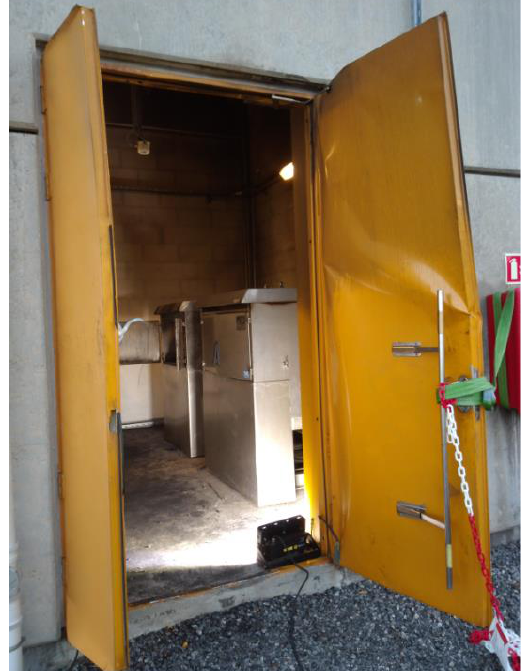
Figure 7. The high-voltage room door after the explosion [16].